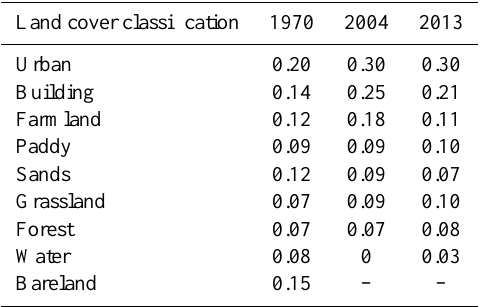
Table 1. Ratio of flood inundation area by geomorphological con- dition.